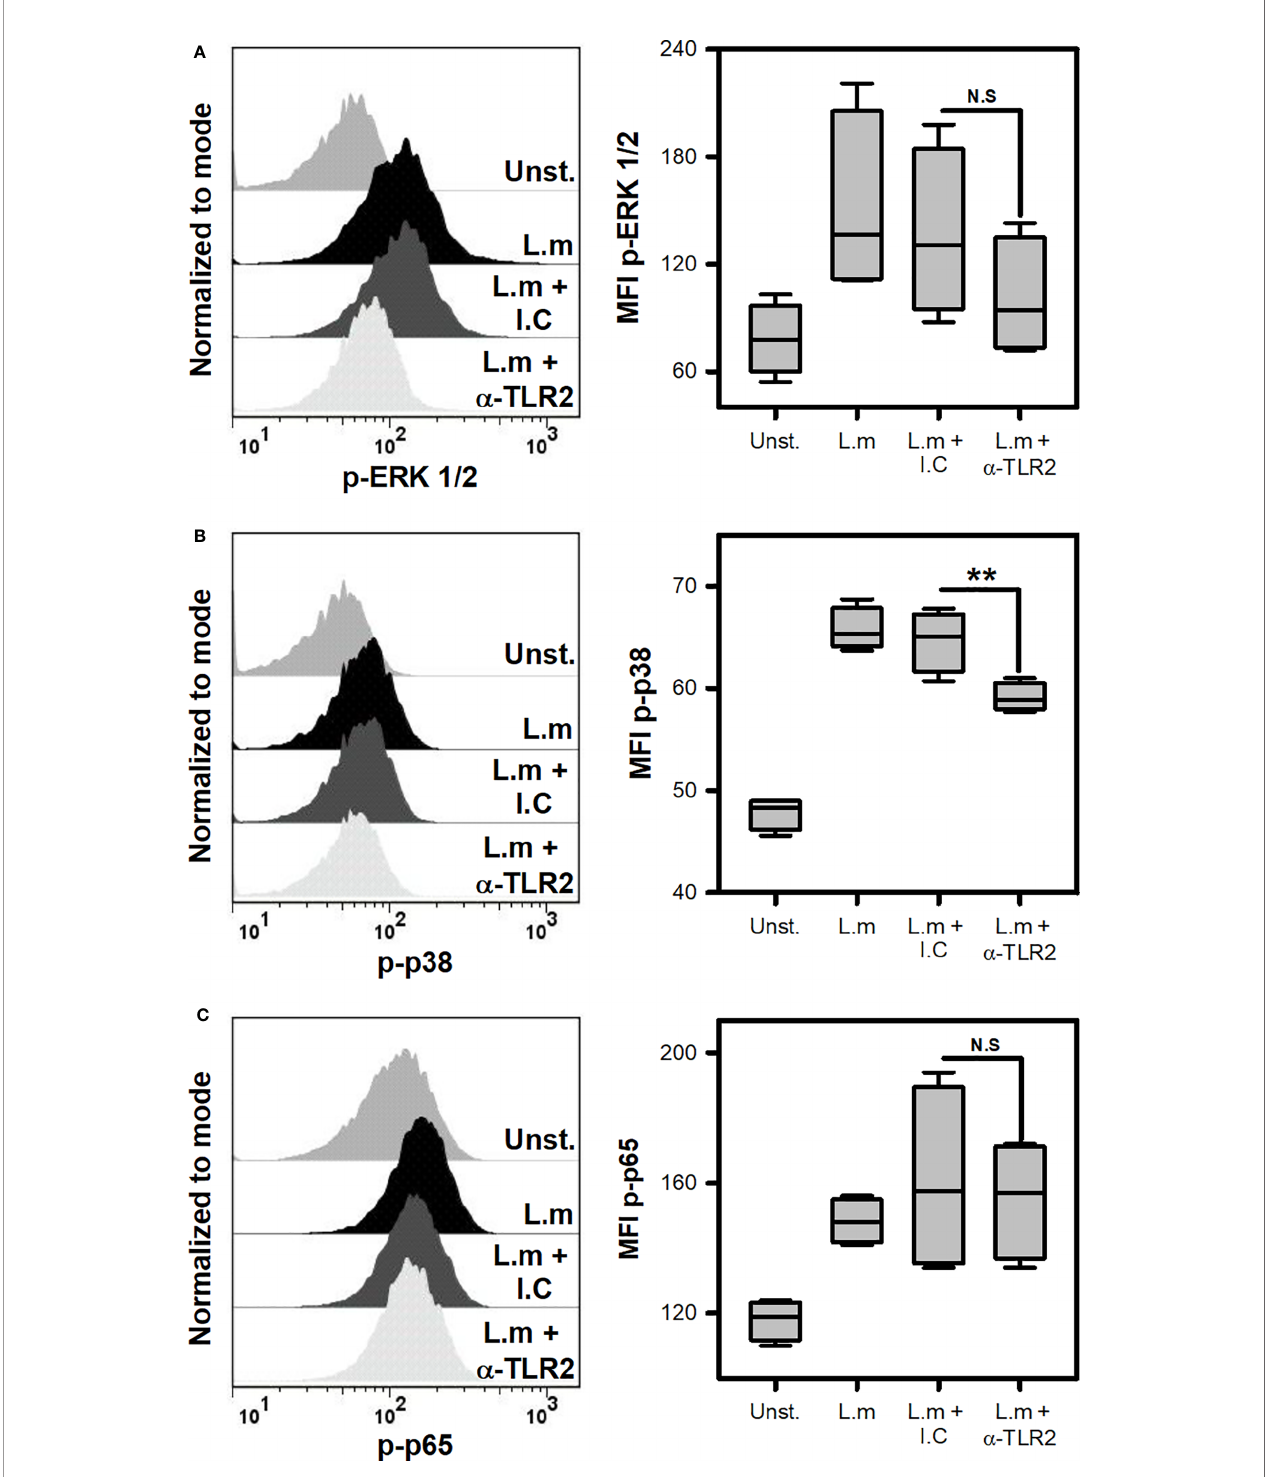
FIGURE 6 | Mast cells TLR2 regulates p38 activation in response to Listeria monocytogenes . 2.5x10 5 BMMC/0.25 mL of complete medium were preincubated with anti-TLR2 for 30 minutes and then were stimulated with L.m (MOI 100:1) for different times to determine the phosphorylation of (A) ERK 1/2 at 15 minutes, (B) p38 at 60 minutes and (C) p65 at 30 minutes by fl ow cytometry. The graphs show the median fl uorescence intensity (MFI). (The fi gure shows the sum of 4 independent experiments, n=4 per group and for each phospho-protein. **p<0.01; N.S, Not Signi fi cance; Kruskal-Wallis